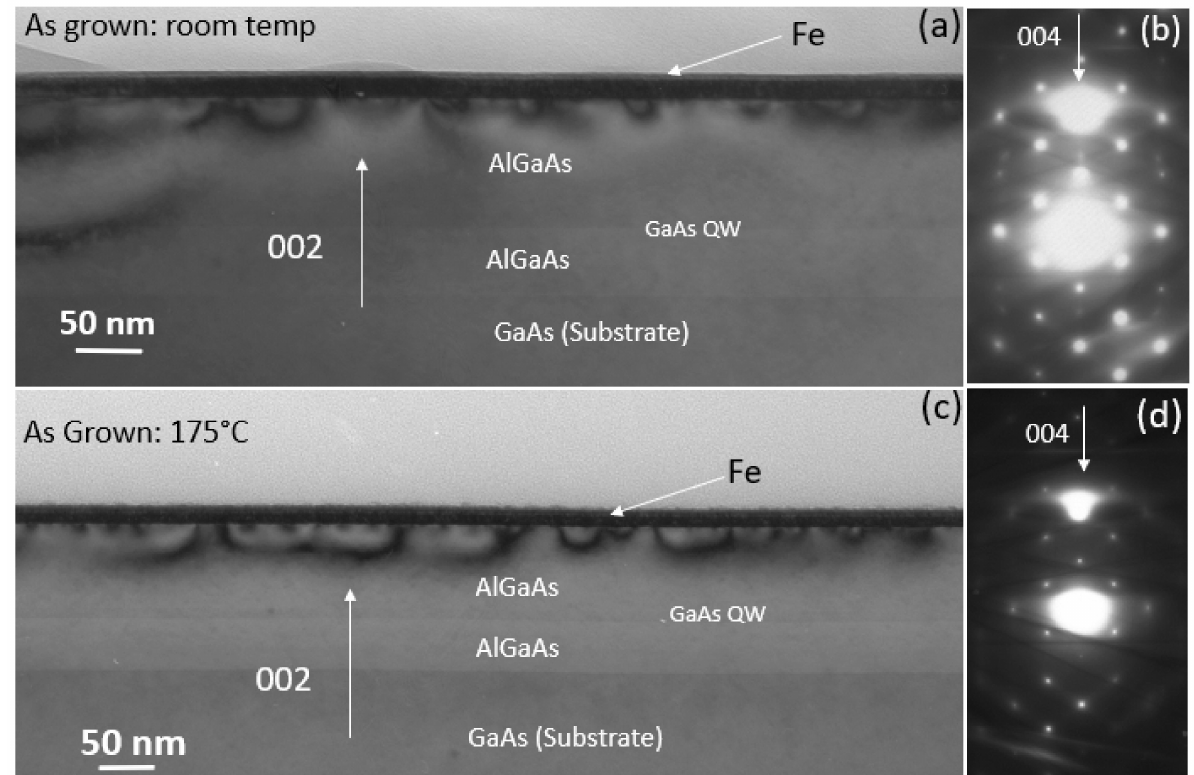
Figure 4. ( a ) A bright-field TEM image showing the strain lobes at the Fe/GaAs interface for the room-temperature-grown sample. ( b ) The corresponding two-beam diffraction condition. ( c ) A bright-field TEM image showing the strain lobes at the Fe/GaAs interface for the 175 ◦ C-grown sample. ( d ) The corresponding two-beam diffraction